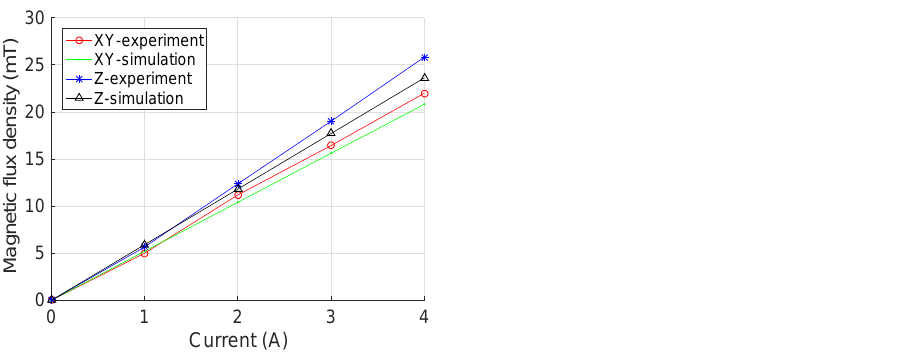
Figure 7. Experimental results of the magnetic flux densities at the center point versus input current.